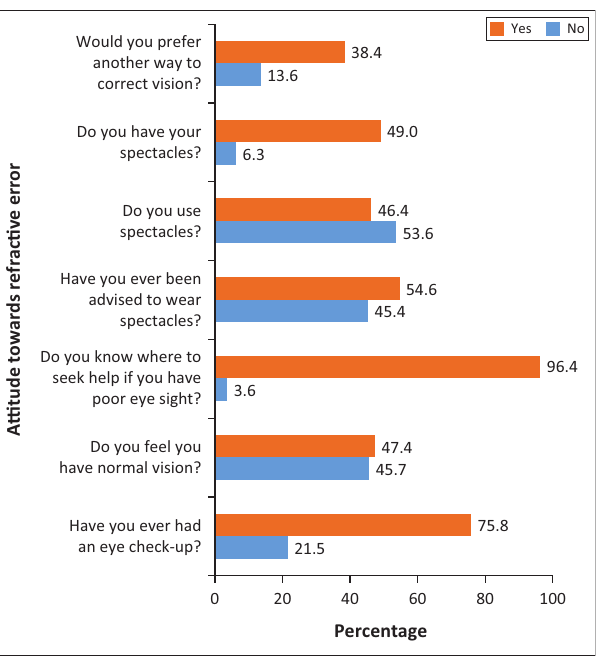
FIGURE 3: Participants’ attitude towards refractive error.